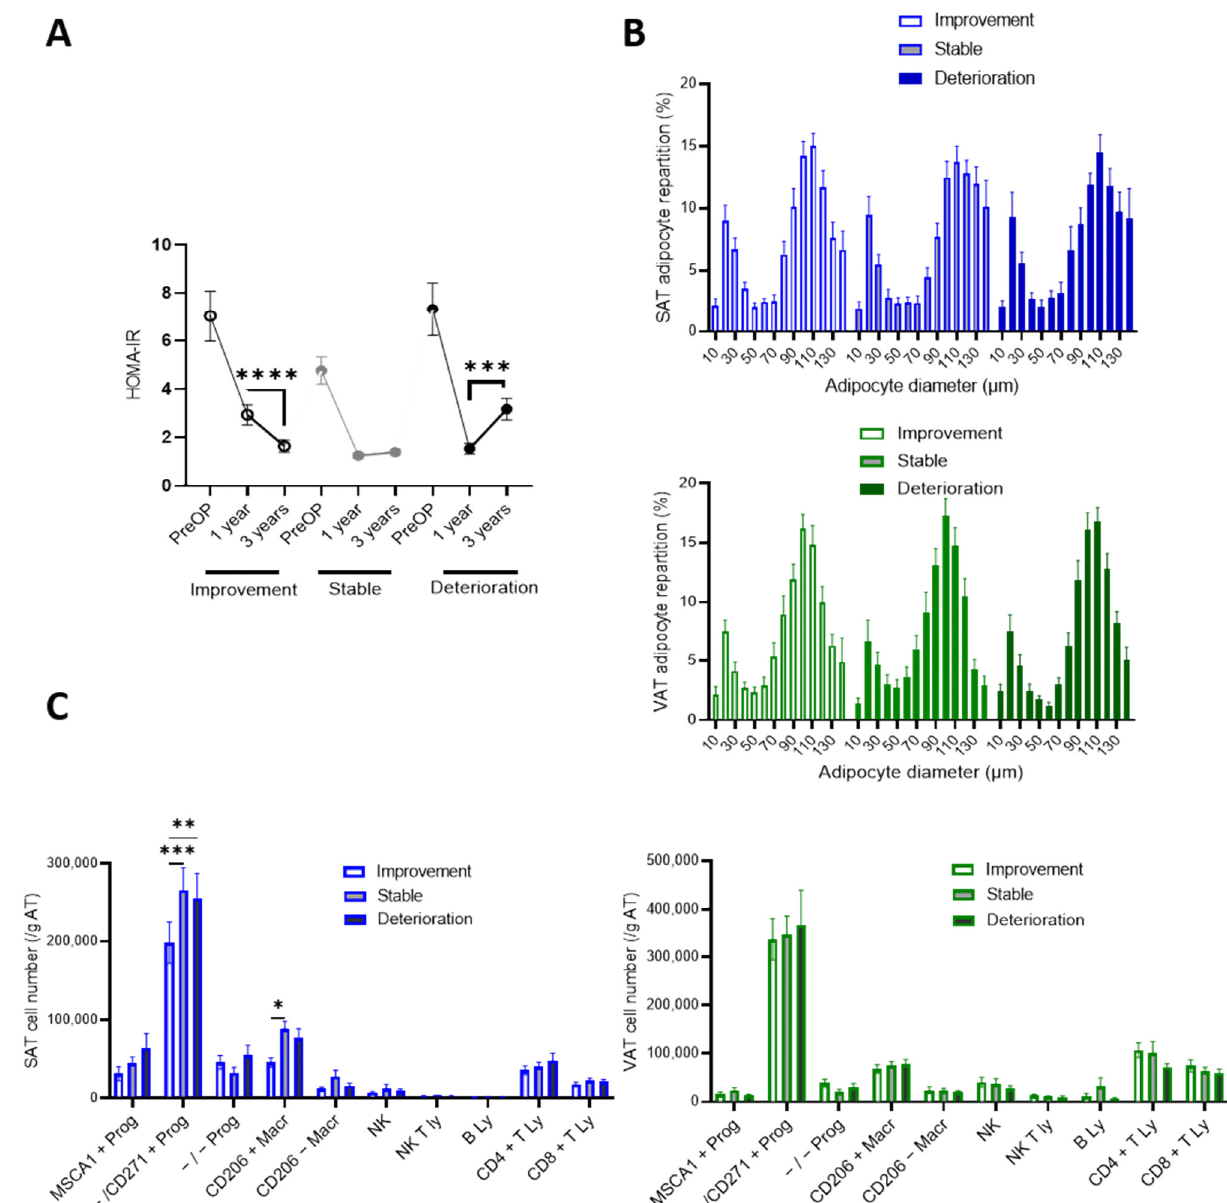
Figure 6. Trajectories of insulin resistance post-BS and cell phenotypes of expanded SAT and VAT. ( A ) Patients were grouped according to the tertiles ( n = 26) of the differences between HOMA-IR at three years and HOMA-IR at one year post surgery with the first tertile qualified as improvement, intermediate tertile as stable and last tertile as deterioration. One-way ANOVA followed by Tuckey multiple comparisons test, ***, p < 0.001 ****, p < 0.0001. ( B ) Adipocyte diameter repartition in SAT (blue) and VAT (green) of patients with IR trajectories. Values are means ± SEM of n = 15 to 17 patients. ( C ) Stromal cell numbers determined by flow cytometry analyses in SAT (blue) and VAT (green) of patients prior to bariatric surgery with IR trajectories. Values are means ± SEM of n = 17 to 21 patients, two-way ANOVA followed by Sidak multiple comparisons test, *, p < 0.05, **, p < 0.01, ***, p < 0.001.